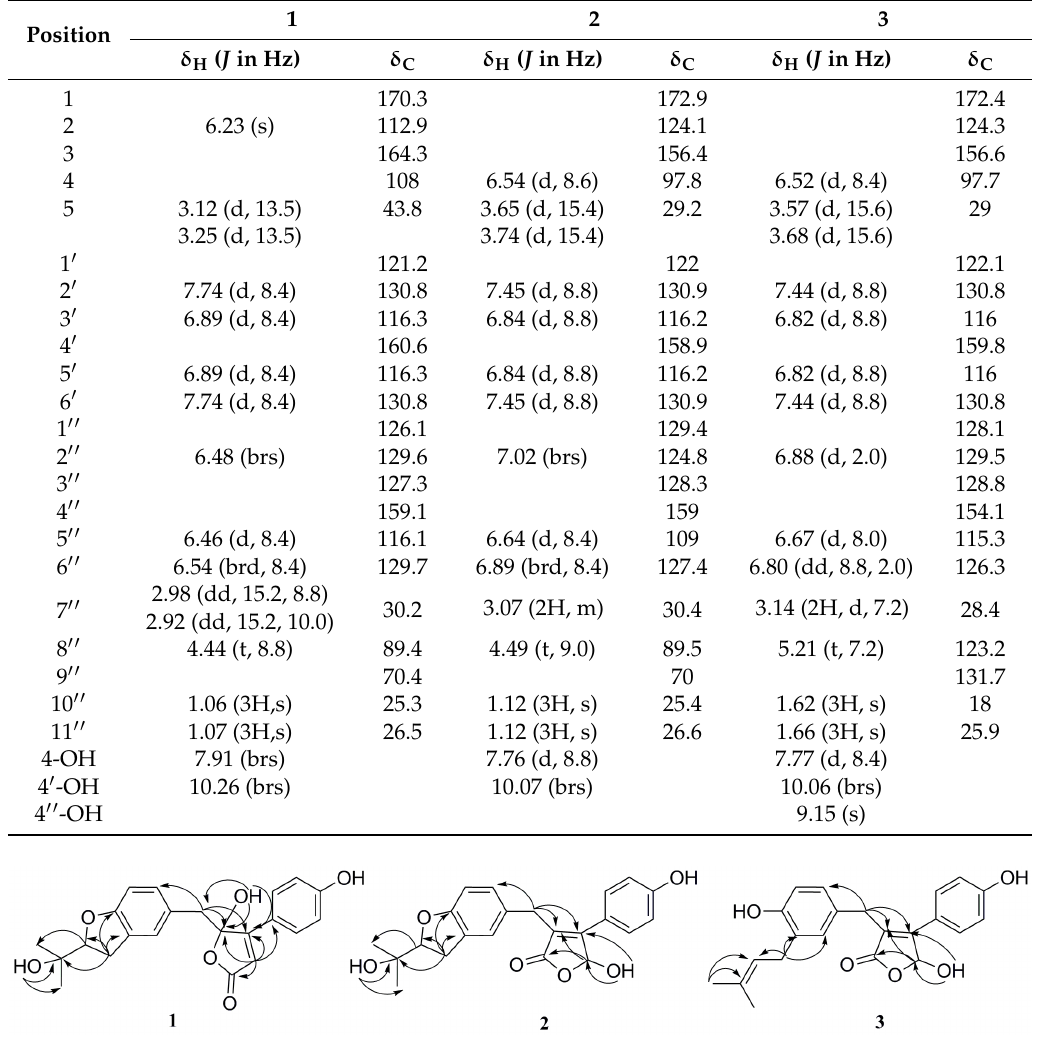
Figure 2. The key HMBC correlations of compounds 1 – 10 .